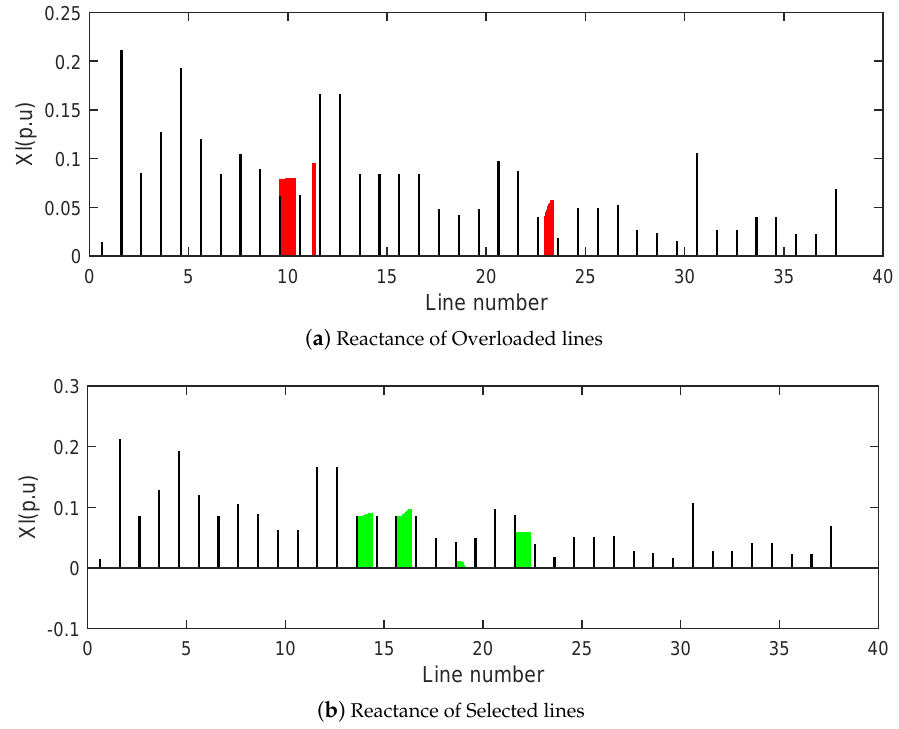
( b ) Reactance of Selected lines Figure 4. Reactance variation of lines in IEEE 24 bus